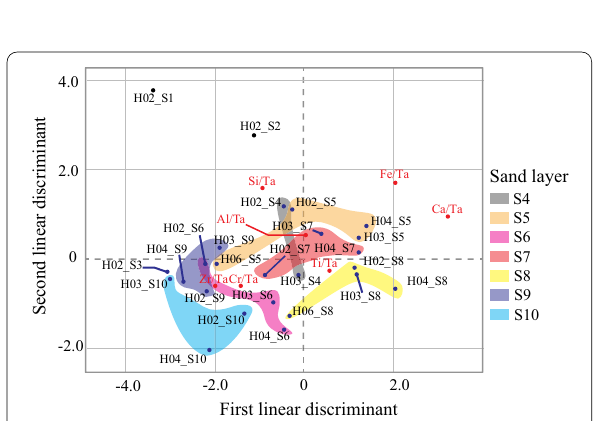
Fig. 9 Linear discriminant analysis results for XRF core scanning results in core H02. Elements used for discrimination: Al, Ca, Cr, Zr, Ti, Fe, and Si, normalized by Ta. Every point corresponds to the component value for every sand layer in every core. Color shades represent correlations among sand